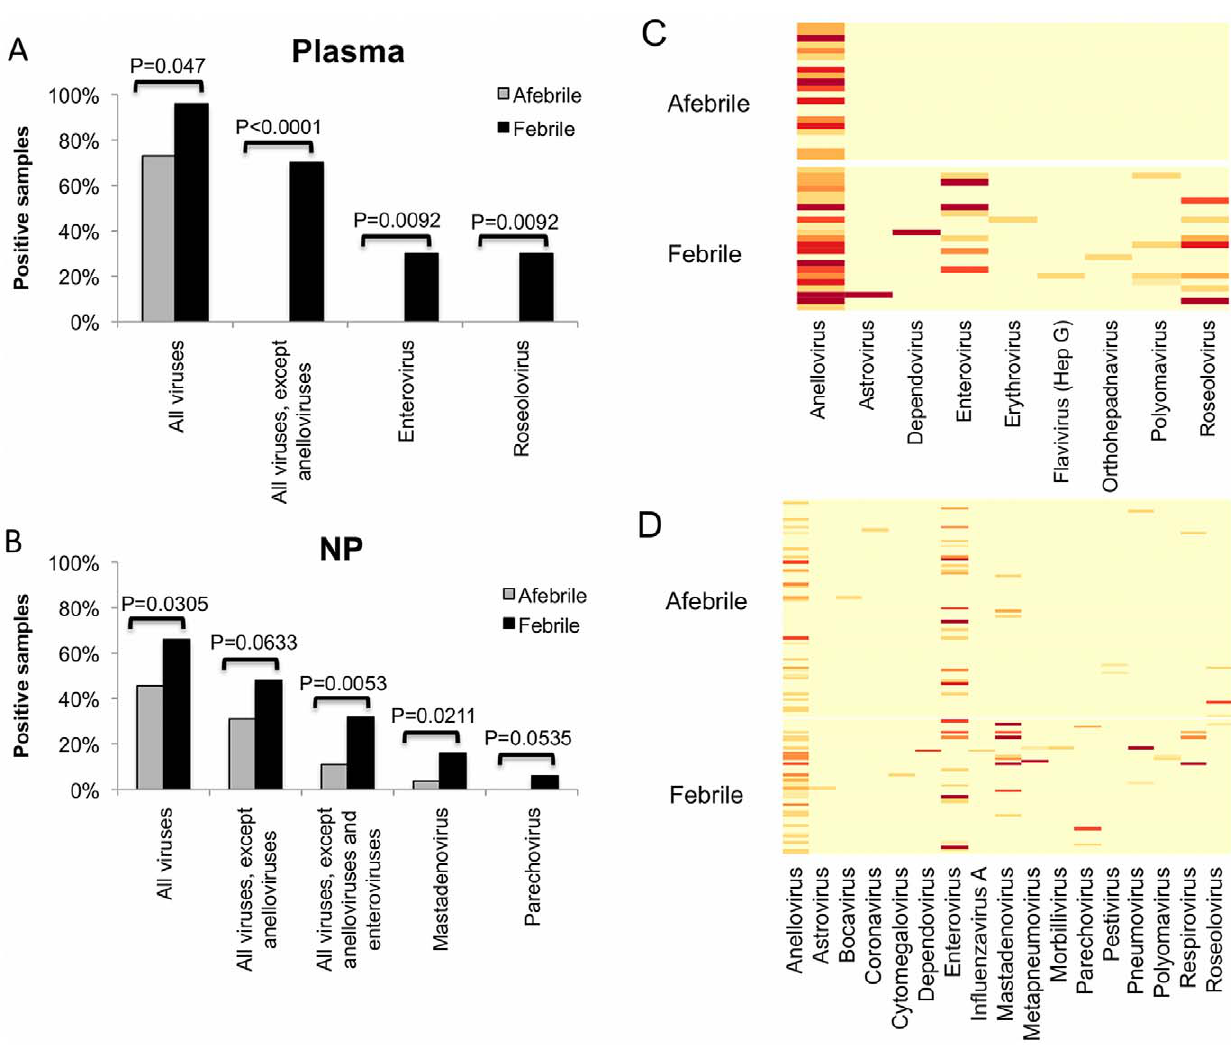
Figure 6. Prevalence of viruses in samples from febrile compared with afebrile children. The total number of reads per sample was scaled to 3 million to make samples more comparable, and all counts of $ 1 virus sequence were reported. The percent virus-positive samples are graphed for plasma and NP samples, respectively (A and B). P-values were determined using Fisher’s exact test. Heatmaps representing the number of virus reads for each virus detected (x-axis) and each sample evaluated (y-axis) are presented for plasma and NP samples, respectively (C and D). The light yellow area is 0 reads, with more intense red representing larger numbers of reads.